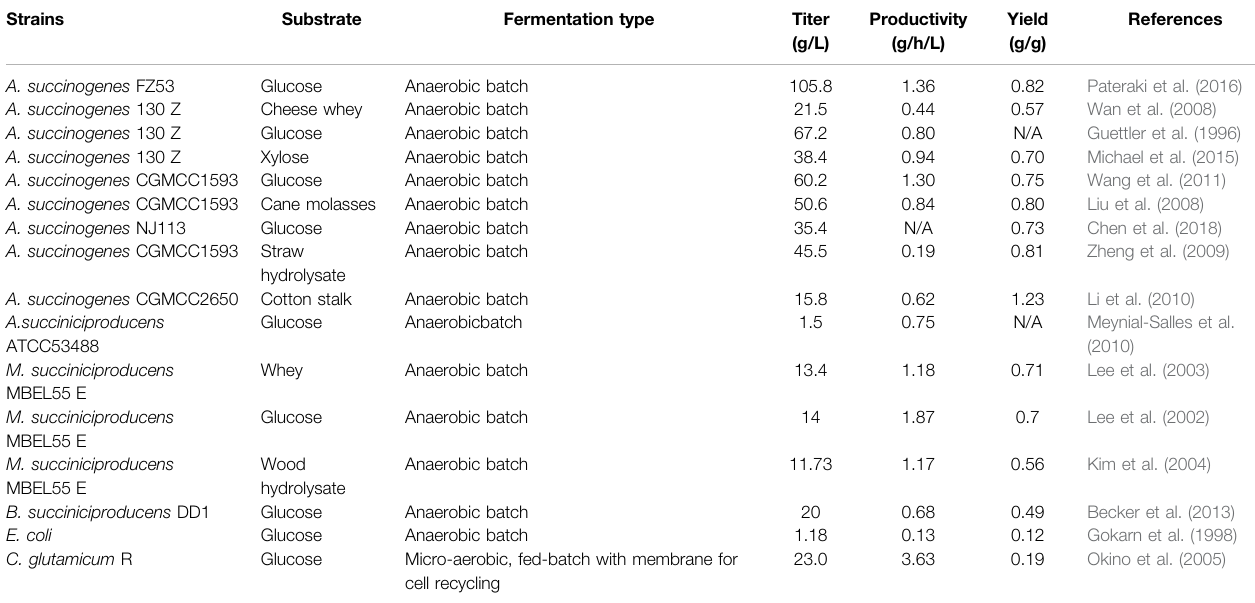
TABLE 2 | Production capacity of succinic acid by main natural